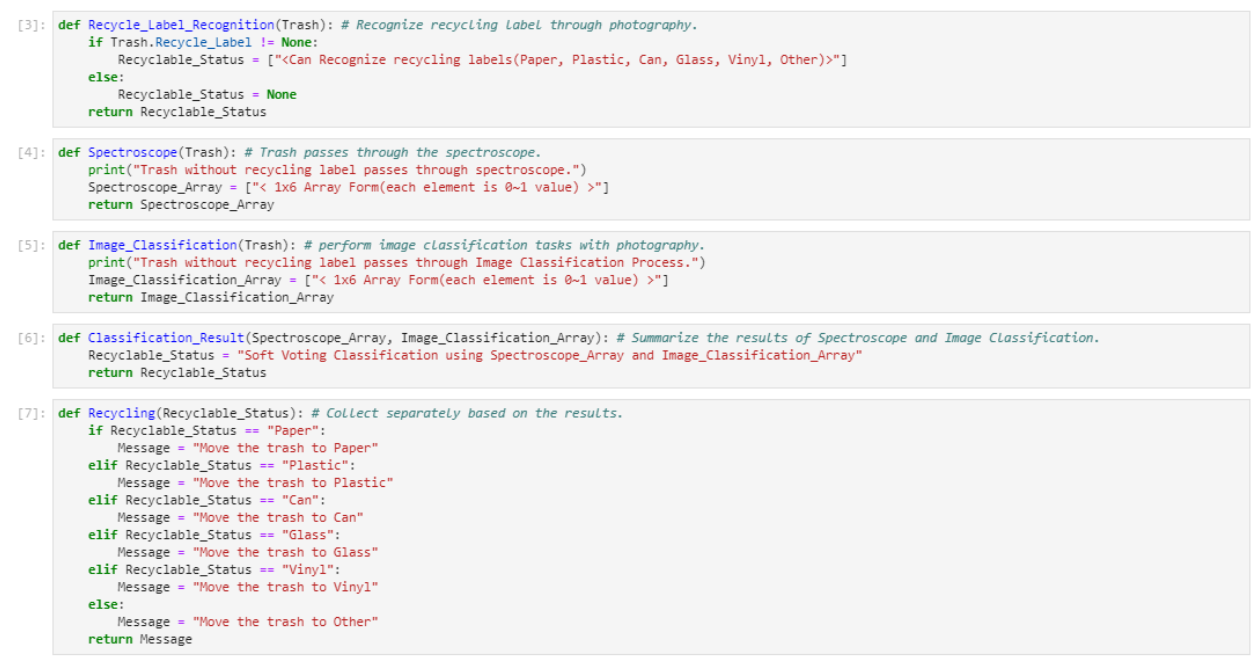
Figure A3. Define Recycle Label Recognition and Classification Process using Python